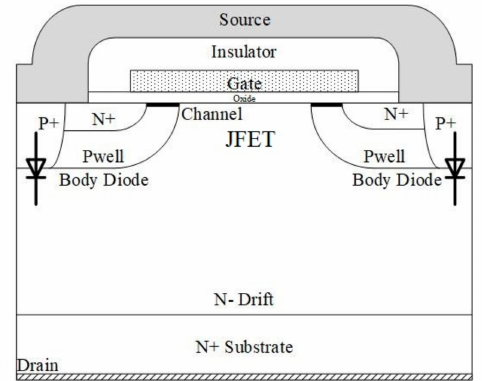
Figure 1. Cell structure of SiC metal-oxide-semiconductor field-e ff ect transistor